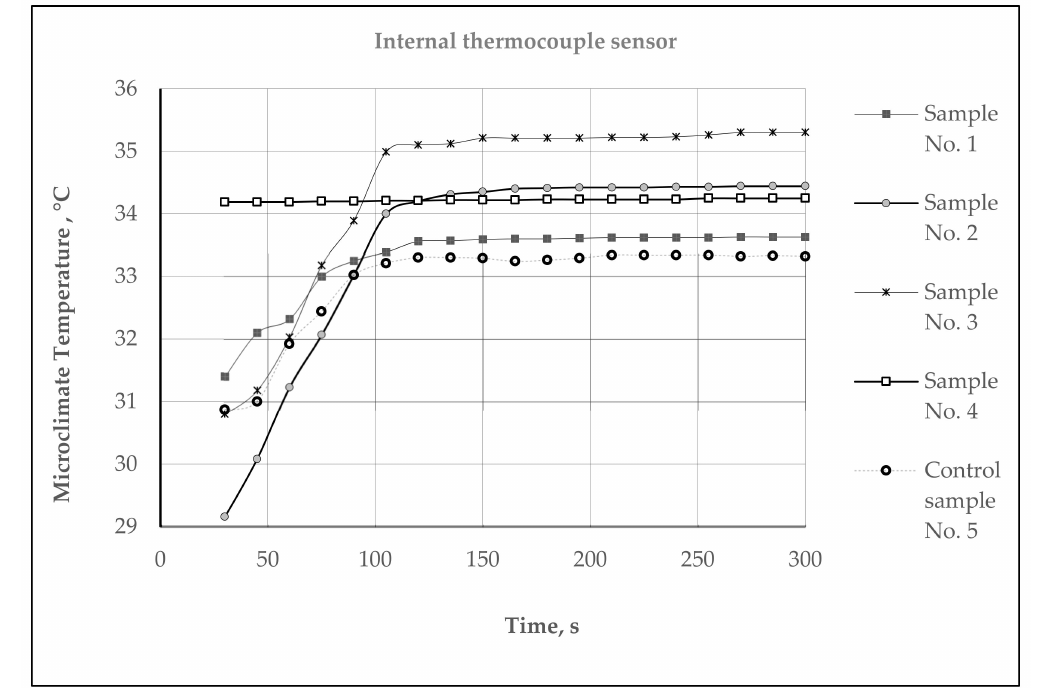
Figure 9. Dynamic curves of the microclimate temperatures of the different structures of socks.